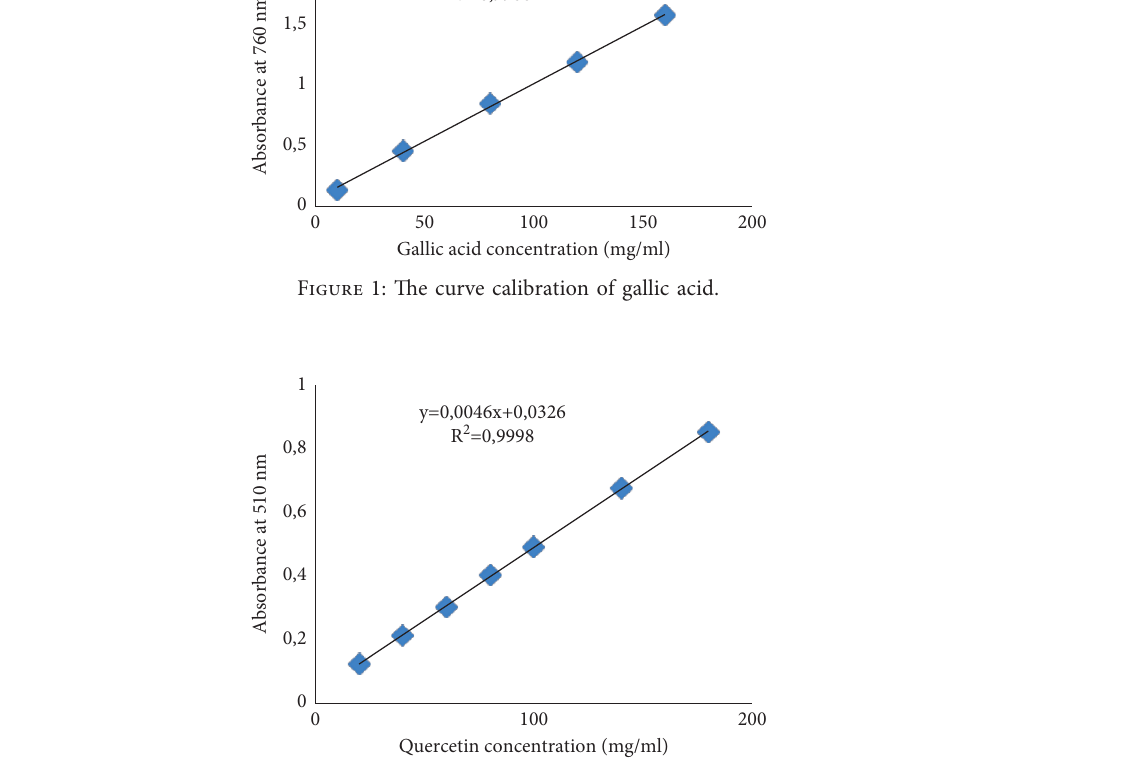
Figure 2: The curve calibration of